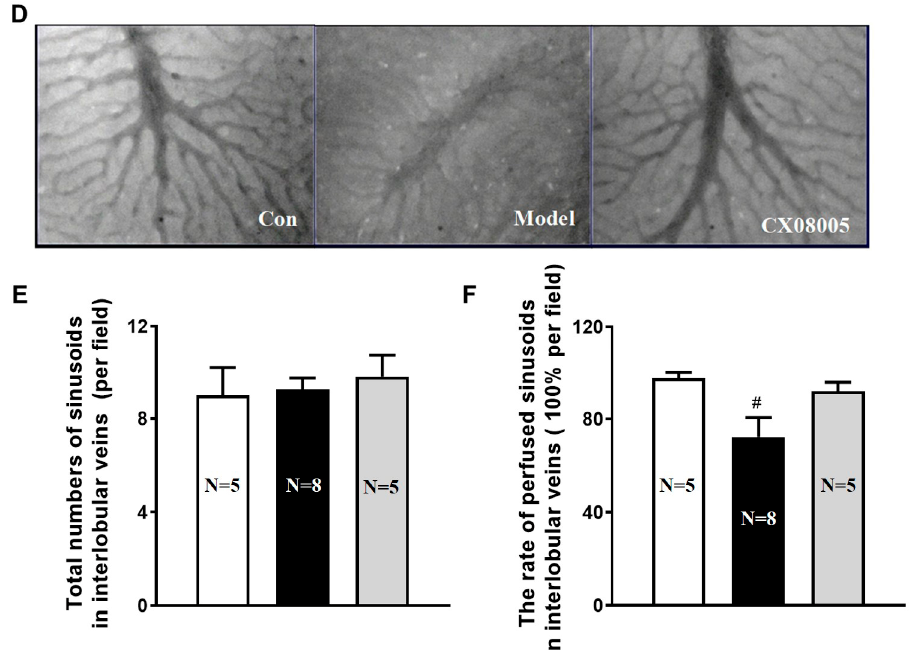
Figure 5. Effects of CX08005 on perfused sinusoids of central veins and interlobular veins in DIO mice. ( A ) Perfused sinusoids of central veins ( × 200). ( B ) Total numbers of sinusoids in central veins. ( C ) Rate of perfused sinusoids of central veins. ( D ) Perfused sinusoids of interlobular veins ( × 200). ( E ) Total numbers of sinusoids in interlobular veins. ( F ) Rate of perfused sinusoids of interlobular veins. Data are shown as means ± SEM. N = 5–8. # p < 0.05, ## p < 0.01, ### p < 0.001 vs. Con; ** p < 0.01 vs. DIO mice.